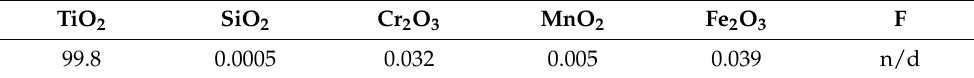
Figure 9. XRD pattern of titanium dioxide after treatment with hydrochloric acid. Table 4. The content of the main components in pigmentary titanium dioxide,